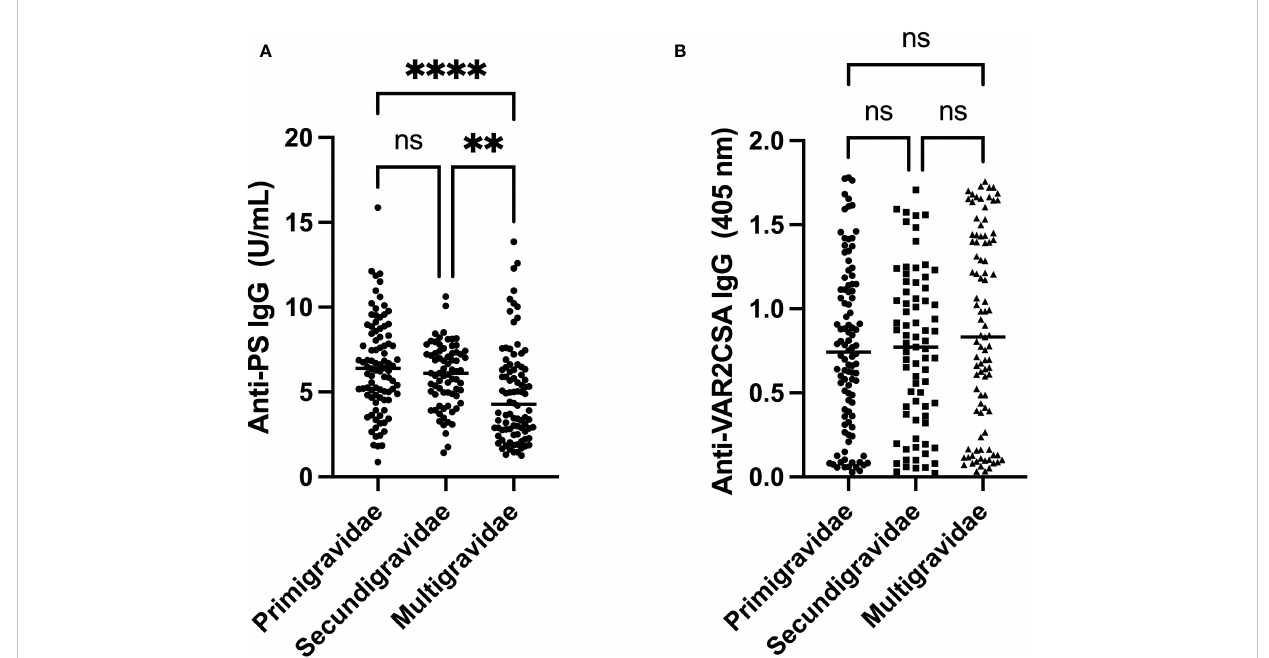
FIGURE 2 Comparison of anti-PS and anti-VAR2CSA antibody levels by gravidity. (A) Anti-PS levels were low in multigravidae when compared to both primigravidae and secundigravidae (** and **** represent p ≤ 0.01 and p < 0.0001, respectively). (B) Anti-VAR2CSA antibody seemed to be highest in multigravidae, but it was not statistically signi fi cant (p = 0.35). ns, not statistically signi fi